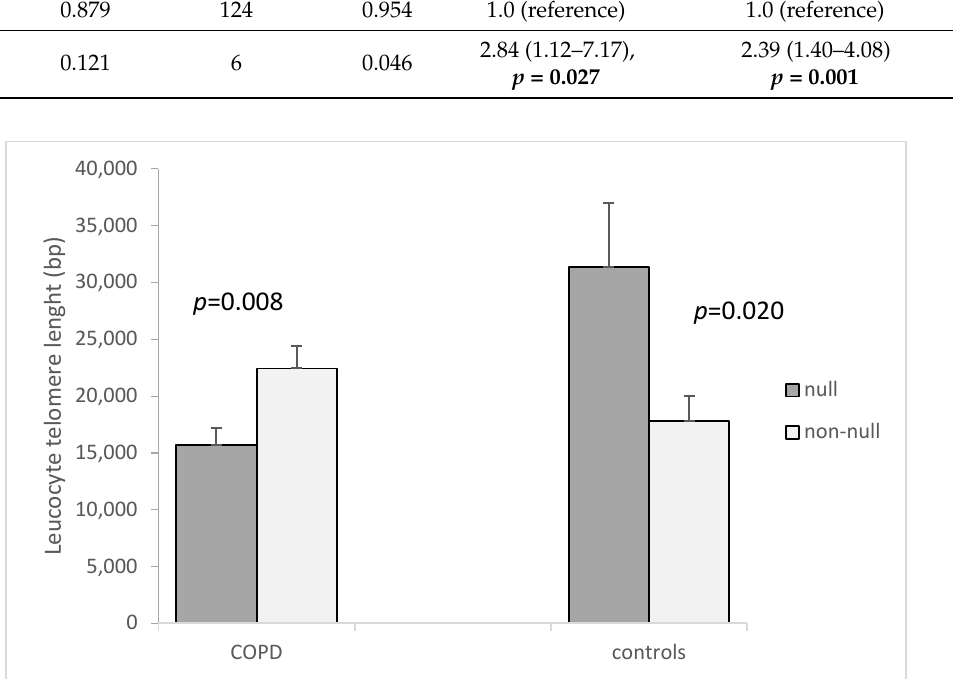
Figure 3. Leucocyte telomere length in COPD patients and controls in GSTM1 and GSTT1 combined genotypes (carriers of either GSTM1 and GSTT1 non-null genotype or at least one null genotype). The LTL is presented as mean ± standard error of mean (SEM). The serum levels of total glutathione were significantly higher in controls with the GSTM1 non-null genotype in comparison to the carriers of the null GSTM1 genotype (15.39 ± 2.01 ng/mL vs. 5.53 ± 0.85 ng/mL, p = 0.002, Figure 4). In COPD patients, we found no difference (non-null: 9.53 ± 2.27 ng/mL vs. null: 13.39 ± 2.26 ng/mL, p = 0.301).